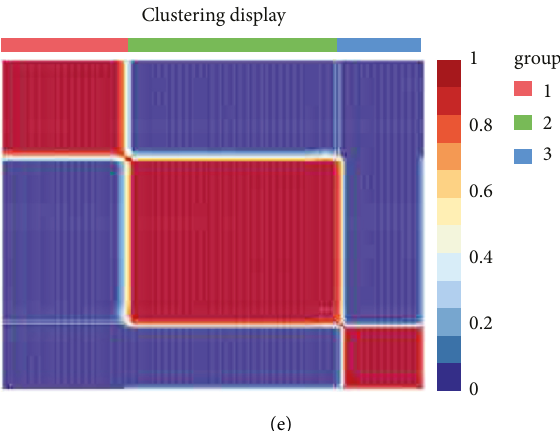
Figure 2: Establishment of subtypes of gastric cancer in TCGA cohort. (a) The optimal cutoff value of cluster was generated. (b) Vi- sualization of cluster plot. (c) Survival patterns were drawn by survival analysis. (d) Silhouette plot was sketched. (e) Three clusters were identified.